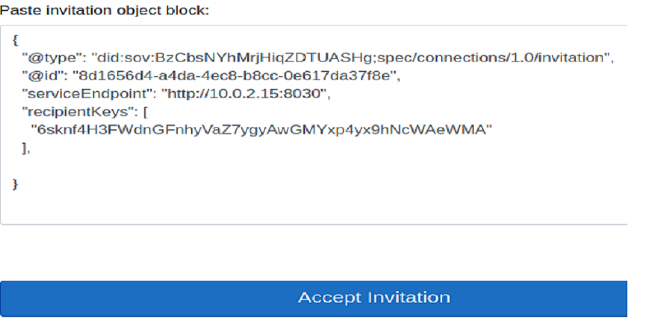
Figure 8. Alice accepts Bob’s invitation.